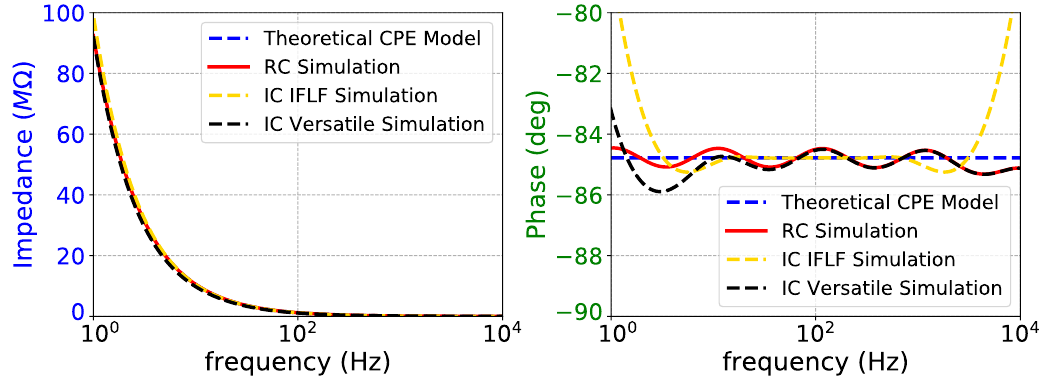
Figure 11. Impedance magnitude ( left ) and phase response ( right ) of the fractional-order capacitor for the case of electrode model.